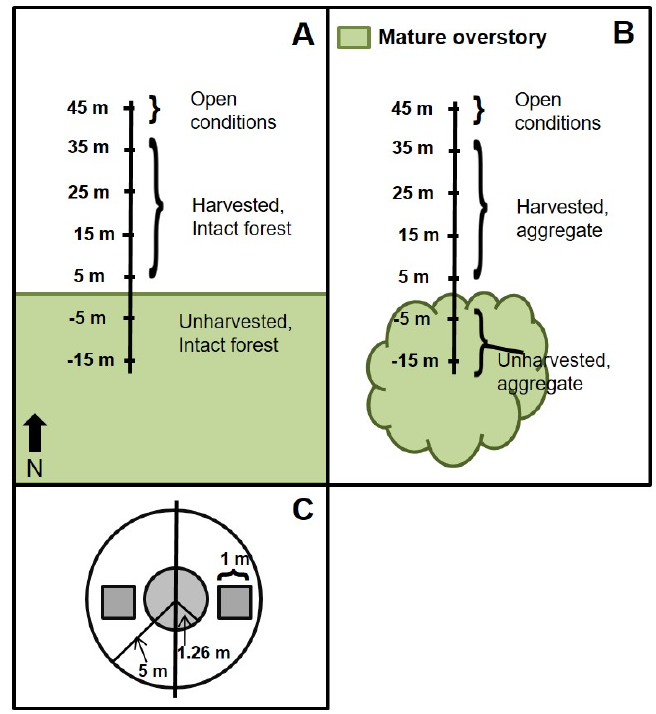
Figure 1. Transect design. Plots along both intact forest ( A ) and aggregate ( B ) transects extend from 15 m within intact canopy (unharvested areas indicated by negative distances) out to 45 m into harvests (positive numbers). The layout of plots centered on each sampling point along each transect is depicted in ( C ). There are two replicates of each transect type at each study site.